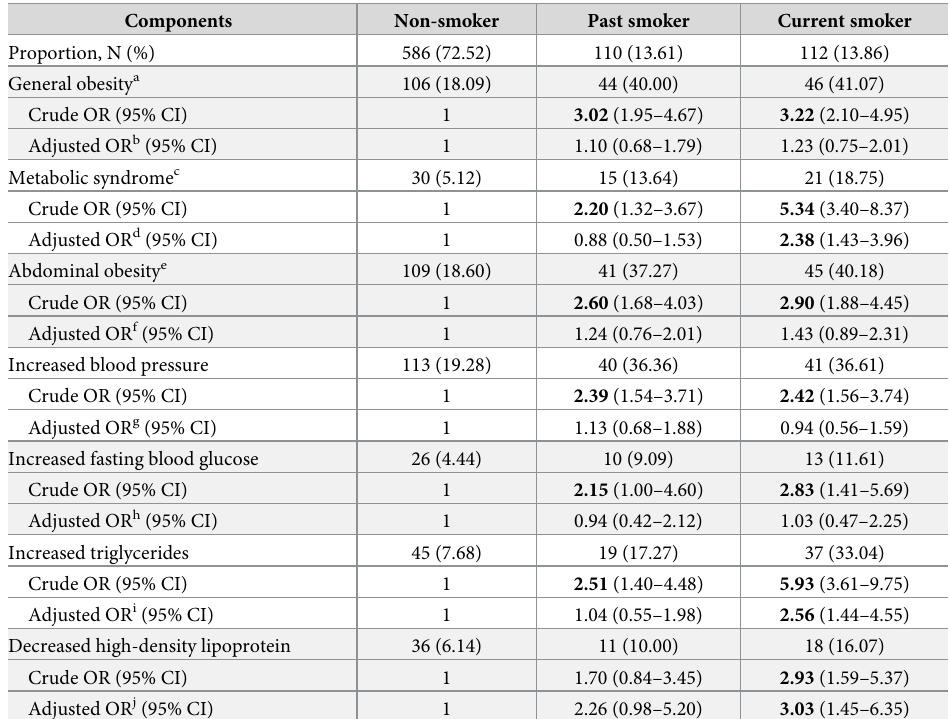
Table 3. Crude and adjusted odds ratios (and 95% confidence intervals) from logistic regression analyses identify- ing associations between smoking status and components of metabolic